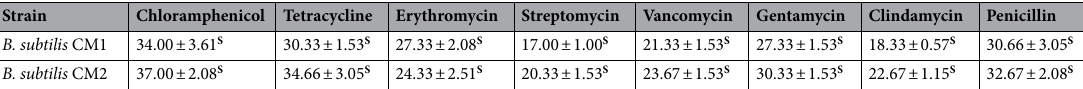
Table 5. Antibiotic susceptibility and antioxidant activity of the Bacillus isolates. Mean ± SD expressing data of inhibition diameter (mm) in three replications. Sensitive (s), Resistance (r).